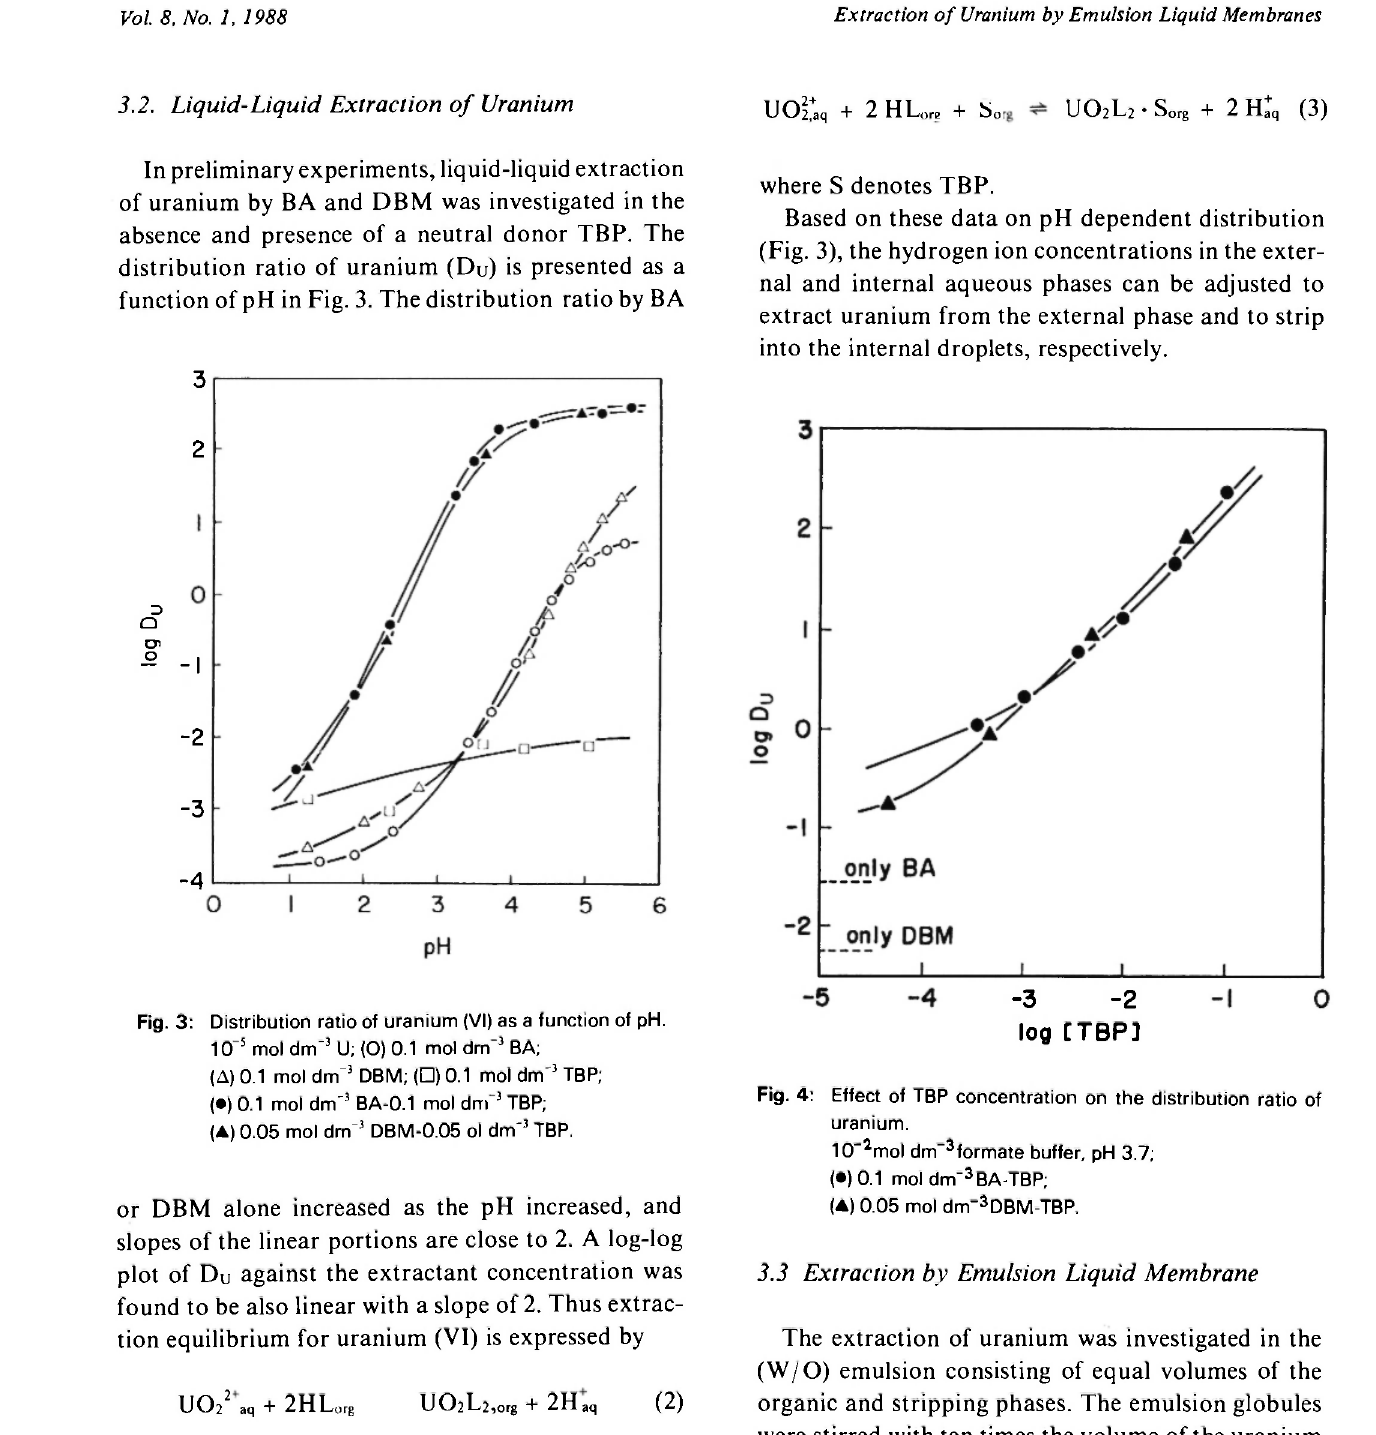
Fig. 4: Effect of TBP concentration on the distribution ratio of